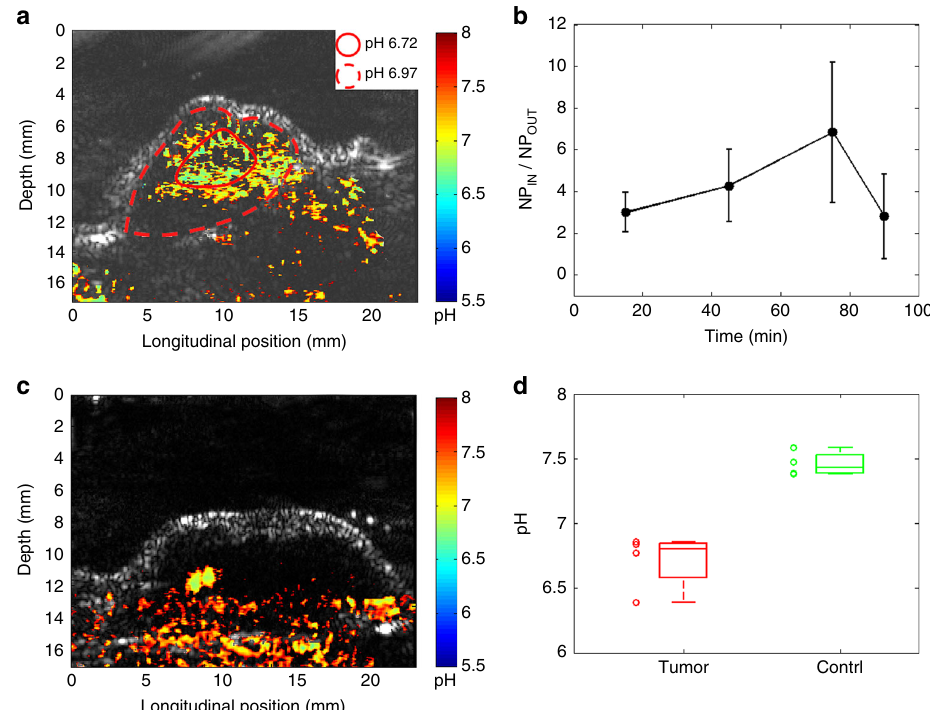
Fig. 6 Statistical analyses of the PAI results from the in vivo mouse model. a A close-up view of the PA pH image of a tumor shown in Fig. 5 (75 min). The pH in the center area (i.e., the area in the solid line) and the peripheral areas (i.e., the area between the solid line and the dash line) are averaged respectively. b Analysis of the SNARF-PAA NP accumulation in the tumors at different time points after systemic injection represented by the ratio between the NP concentrations inside and outside the tumor (NP IN /NP OUT ). With the measurements from four animals ( n = 4), the average and the standard error for each time point are presented. c Example PA pH image of a normal tissue (i.e., thigh), showing relatively higher pH. d The boxplot showing the pH levels in tumors ( n = 4) vs. the pH levels in normal tissues (i.e., thigh) ( n = 4), as quanti fi ed from PA pH images. The measurements from individual sample (tumors and thighs) are also presented by scattered